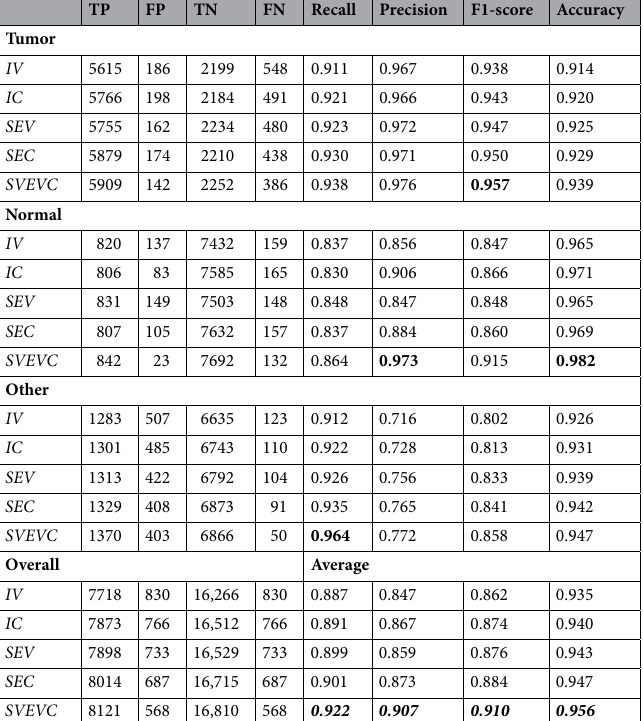
Table 1. The detail of statistical measures of five proposed deep learing classifications reported with 30 slides in evaluation B. We highlight (in bold) the best results of: Recall, Precision, F1-score and Accuracy grouped by tissue classes and average of all classes. It shows that the SVEVC method obtains the best classification performance.